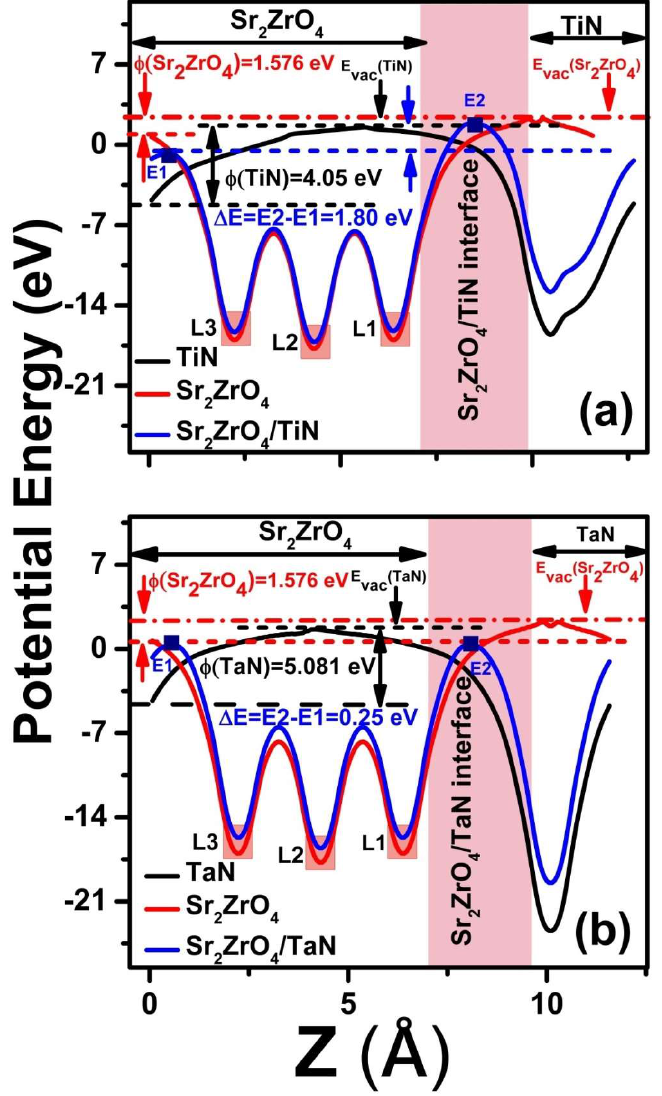
Figure 4. Potential energy lineups of pristine ( a ) Sr 2 ZrO 4 , TiN, Sr 2 ZrO 4 /TiN and ( b ) Sr 2 ZrO 4 , TaN and Sr 2 ZrO 4 /TaN. Pink highlighted region labelled L1, L2 and L3 as an indicative of three layers formed inside the Sr 2 ZrO 4 layered Ruddleson–Popper perovskite structures.